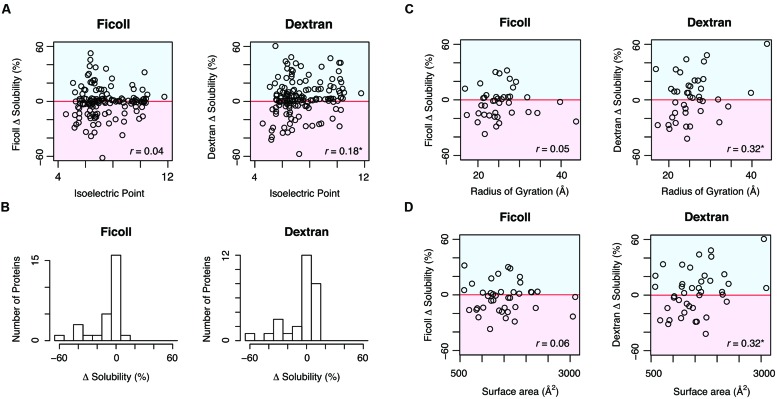
Comparison between the solubility change by MCRs and the properties relevant to the primary amino acid sequences and structural features. (A) Comparison between the calculated isoelectric point and the solubility change by Ficoll 70 and dextran 70. The Pearson’s correlation coefficients were 0.04 (p = 0.65) for Ficoll 70 and 0.18 (∗p < 0.05) for dextran 70. (B) Distribution of the solubility changes by MCRs among the proteins with aggregation-prone SCOP folds, observed in the previous report. The SCOP folds were annotated with the SUPERFAMILY database. The number of the proteins with aggregation-prone SCOP folds was 28. (C) Scatter plot of the radius of gyration and the solubility changes by MCRs. The Pearson’s correlation coefficients were 0.05 (p = 0.76) for Ficoll 70 and 0.32 (∗p < 0.05) for dextran 70. (D) Scatter plot of the main chain surface area and the solubility changes by MCRs. The Pearson’s correlation coefficients were 0.06 (p = 0.71) for Ficoll 70 and 0.32 (∗p < 0.05) for dextran 70.